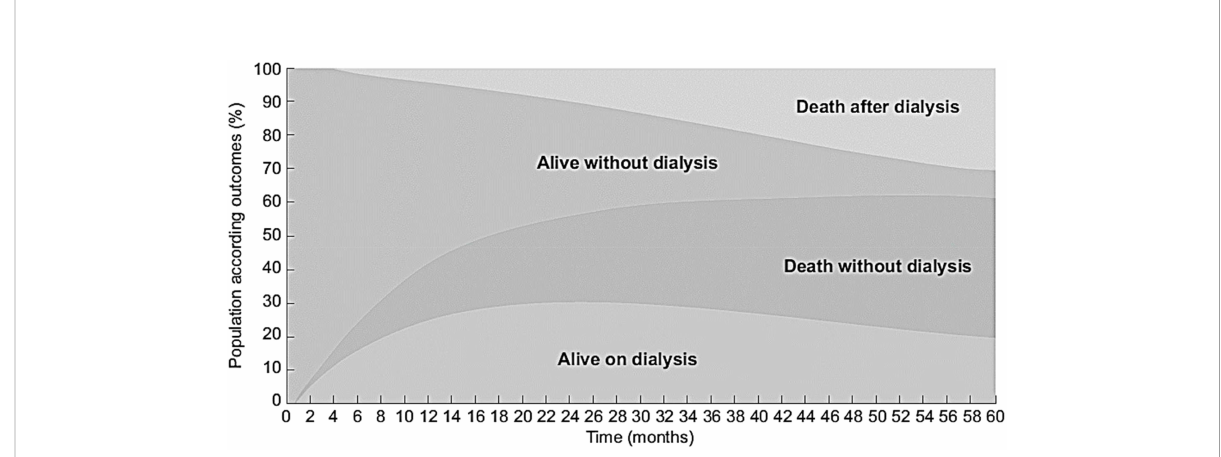
FIGURE 2 Evolution of the PSPA cohort with outcome according to time since inclusion for 573 CKD patients aged ≥ 75 years with eGFR < 20 ml/min/ 1.73m2 (source PSPA cohort linked to REIN registry). Adapted from (41,